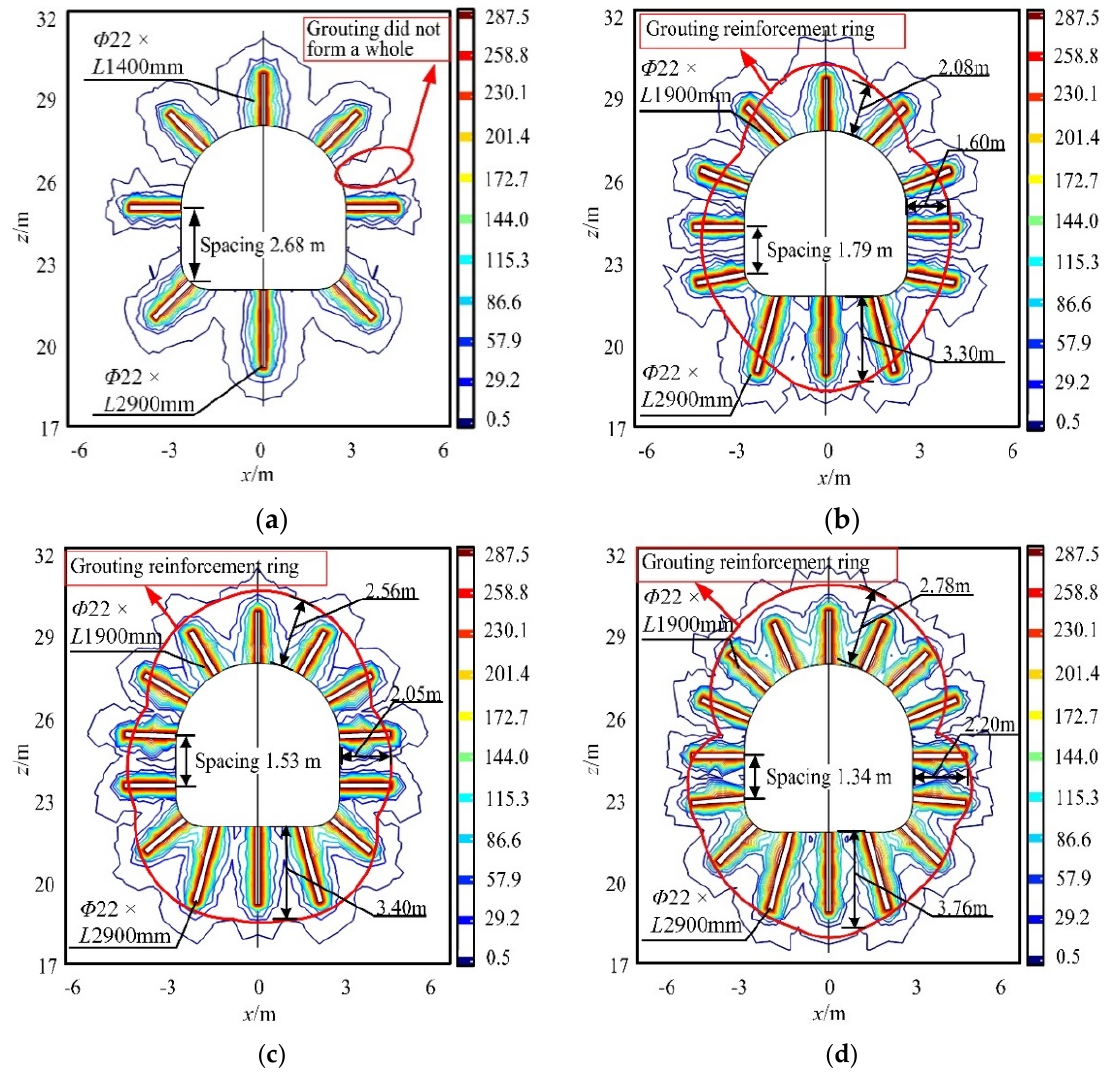
Figure 9. Grouting bolt layout and grout diffusion effect in cross-section (i.e., xz plane) of roadway. ( a ) Spacing 2.68 m; ( b ) spacing 1.79 m; ( c ) spacing 1.53 m; ( d ) spacing 1.34 m.